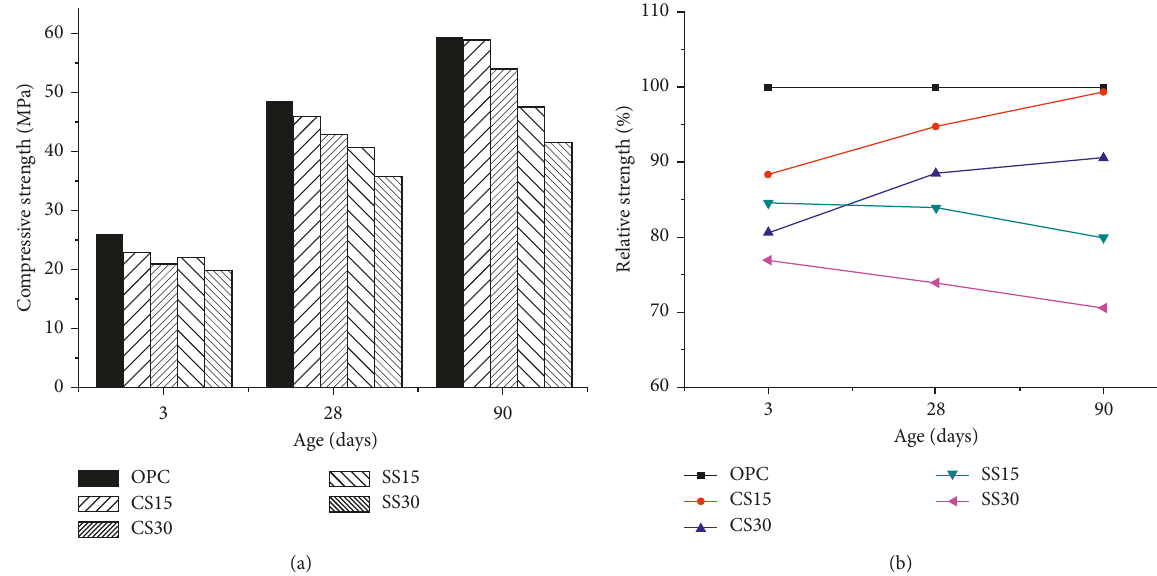
Figure 8: (a) The compressive strength and (b) the relative strength of different slag-cement ratios at 3, 28, and 90